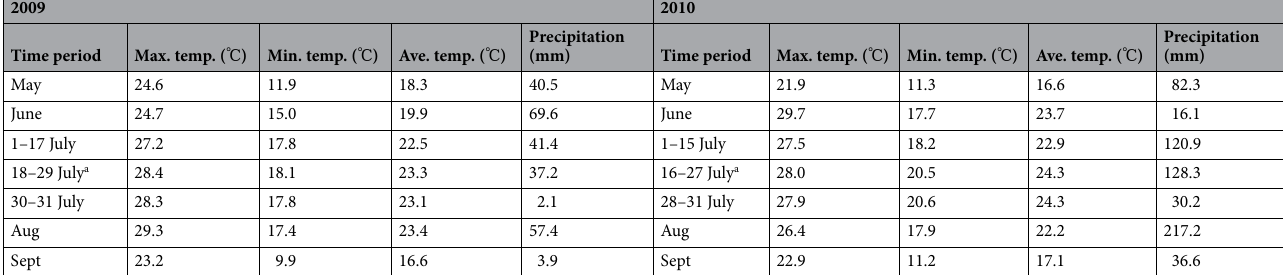
Table 1. Mean monthly minimum (min. temp.), maximum (max. temp.), and average temperature (ave.temp.) and precipitation from May through September at experimental site in 2009 and 2010. a Flowering